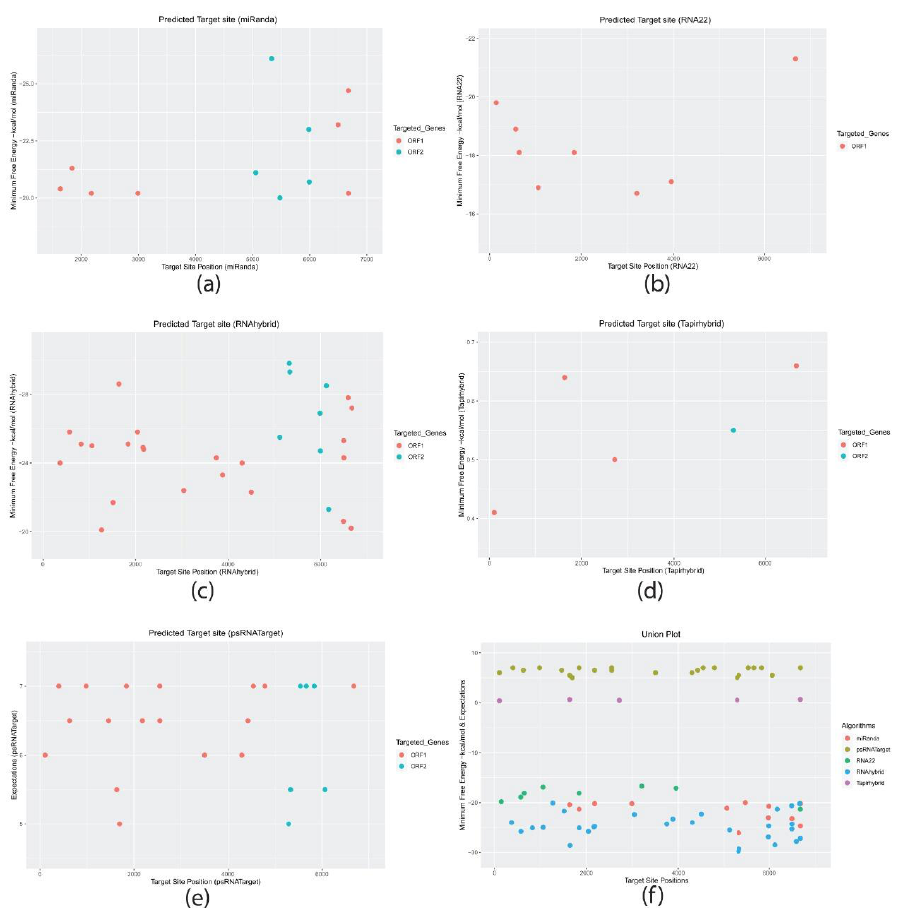
Figure 4. miRNA target prediction results of rubber tree virus 1. Five miRNA target prediction algorithmic tools, including ( a ) miRanda, ( b ) RNA22, ( c ) RNAhybrid, ( d ) Tapirhybrid and ( e ) psRNATarget, were used in this study. ( f ) miRNA prediction results represented as a union of multiple algorithms. Table 1. Rubber tree miRNAs and their target binding sites in the RTV1 genome predicted by different algorithms in this